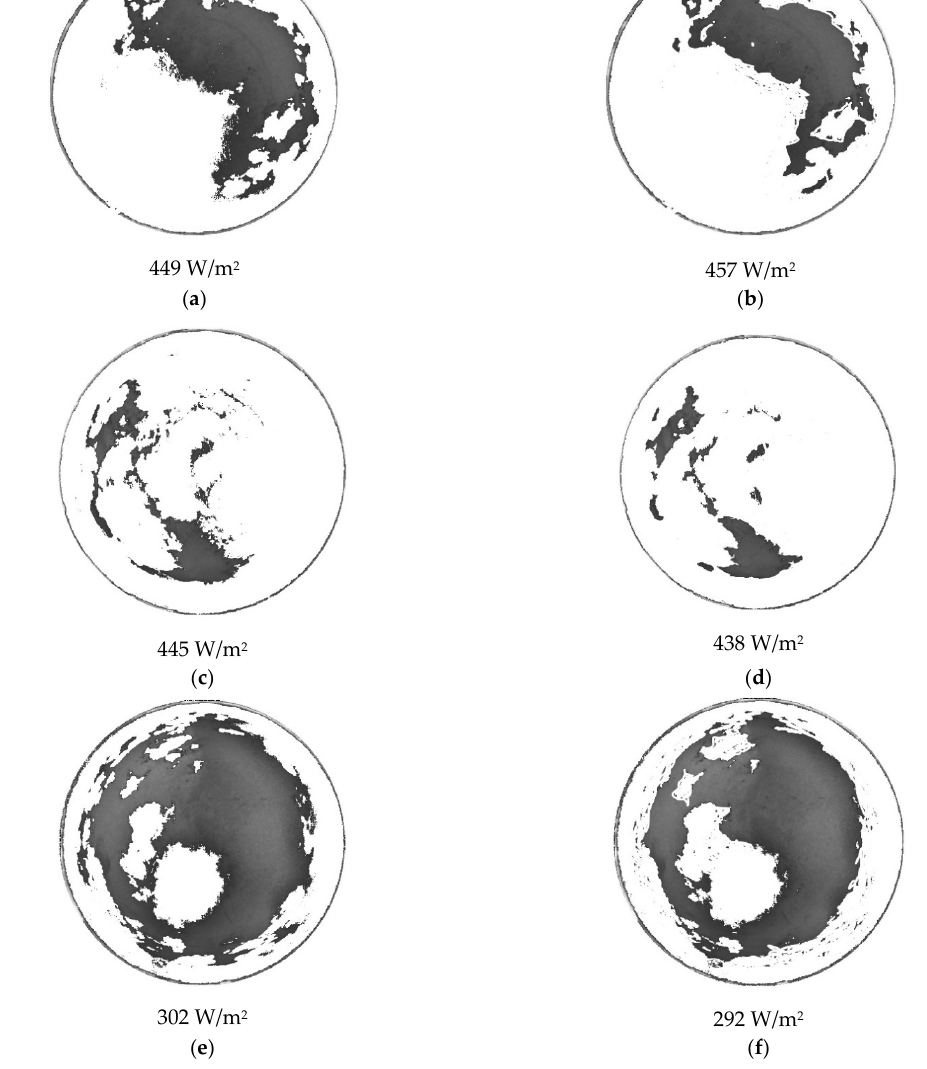
Figure 4. Comparison between the observed images and simulated images one-minute ahead generated as output by the CNN and their correspondent measured and simulated global horizontal irradiance (GHI) values; ( a ) corresponds to 24 August 2014 at 09:45 with ( b ) as its simulations; ( c ) corresponds to 8 June 2015 at 15:10 with ( d ) as its simulations; ( e ) corresponds to 9 May 2017 at 10:42 with ( f ) as its simulations.